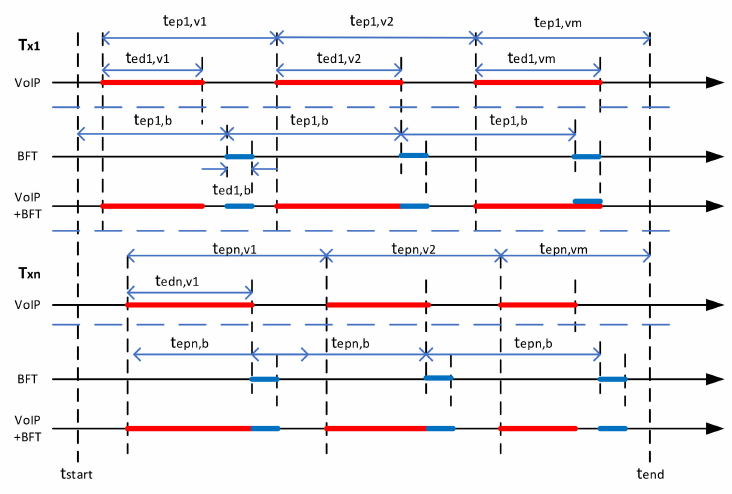
Figure 7. Traffic parametrization.